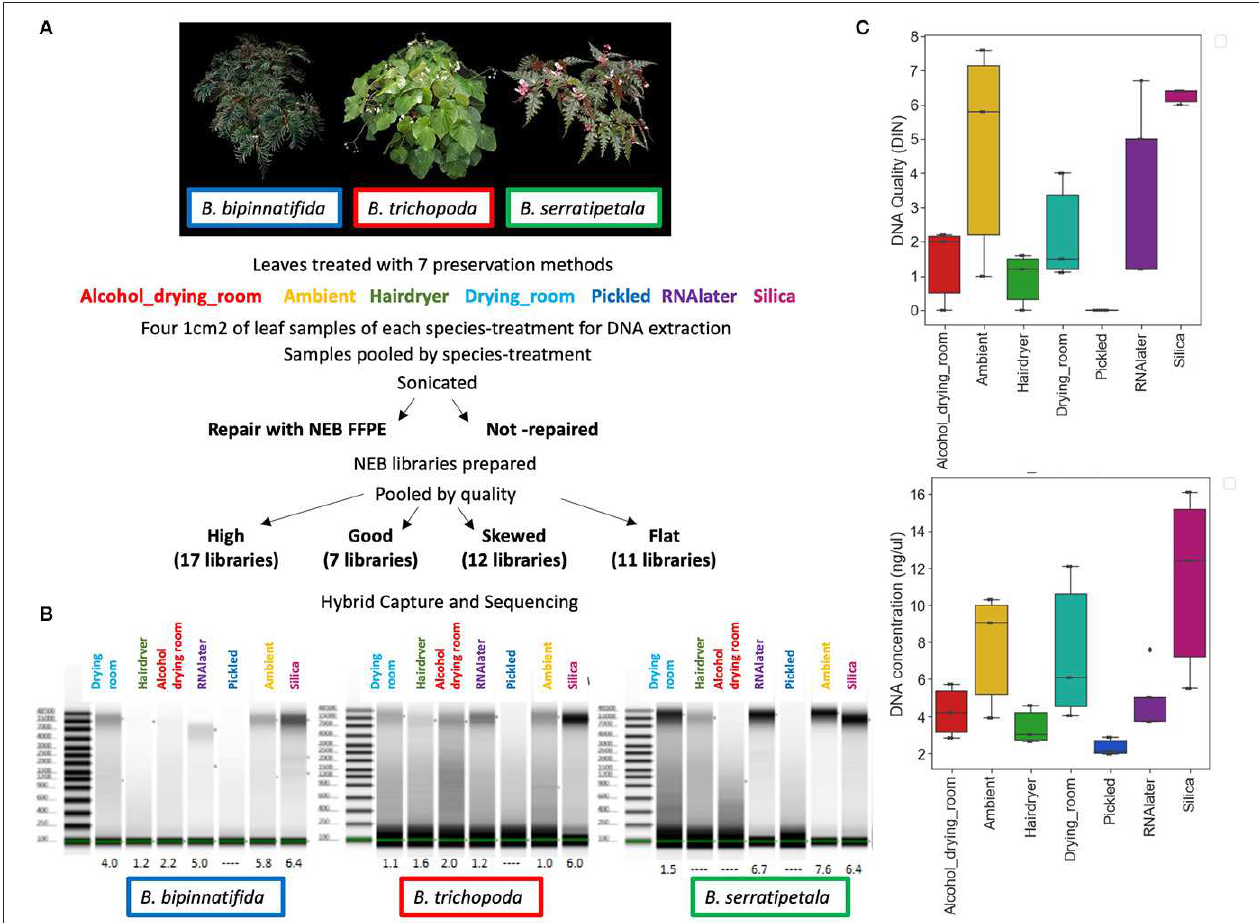
FIGURE 1 | DNA quality and quantity. (A) Individuals sampled: B. bipinnatifida (RBGE living accession 20090801), B. trichopoda (RBGE living accession 20161284), B. serratipetala (RBGE living accession 19681637) and treatment scheme (see section Materials and Methods). (B) Tapestation images of DNA from 4 pooled extractions, prior to splitting the extractions into FFPE repair/not-repair aliquots, with DIN values listed at base. “No DIN assignable” is represented as a dash. (C) Effect of drying method on DNA quality and concentration by treatment ( N = 3, one for each species). “No DIN assignable” is represented numerically as zero.